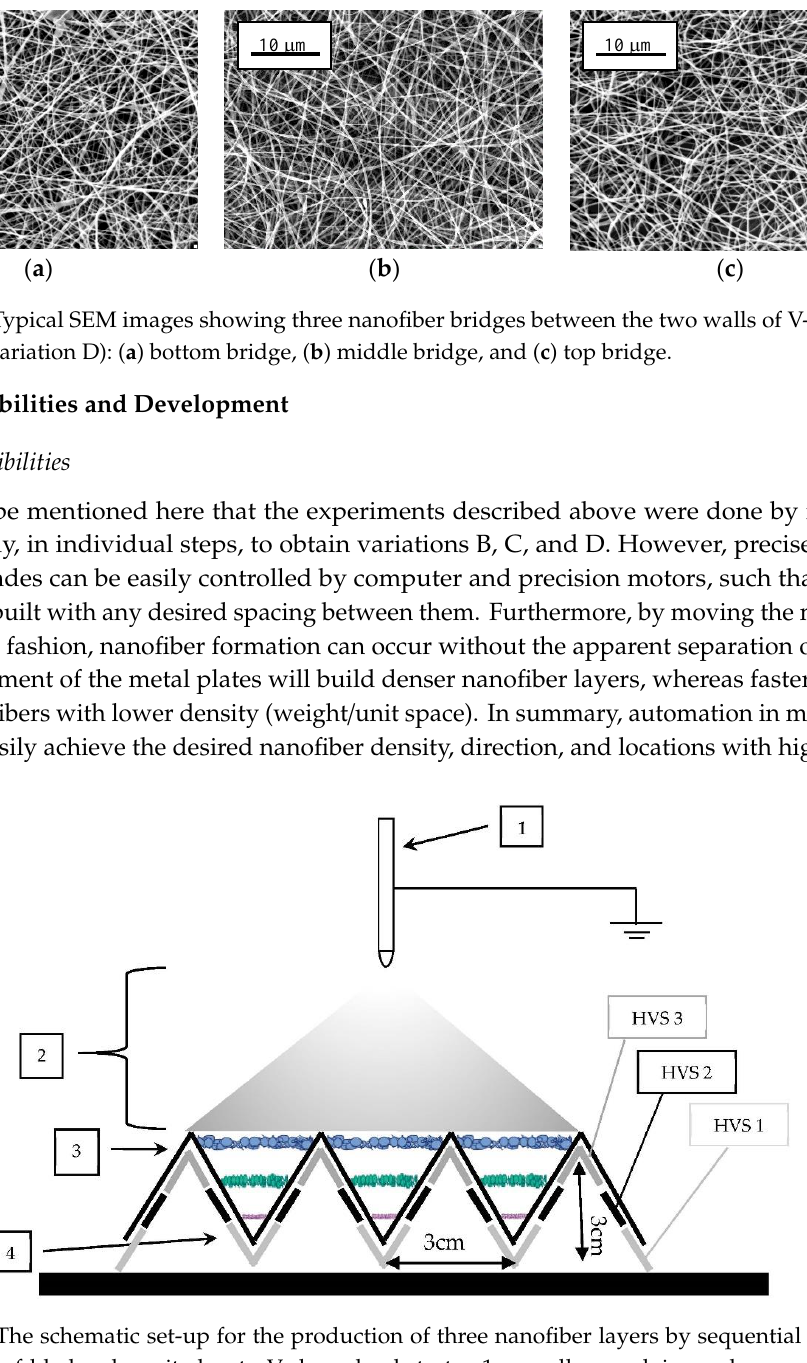
Figure 11. Typical SEM images showing three nanofiber bridges between the two walls of V-shaped substrate (variation D): ( a ) bottom bridge, ( b ) middle bridge, and ( c ) top bridge.